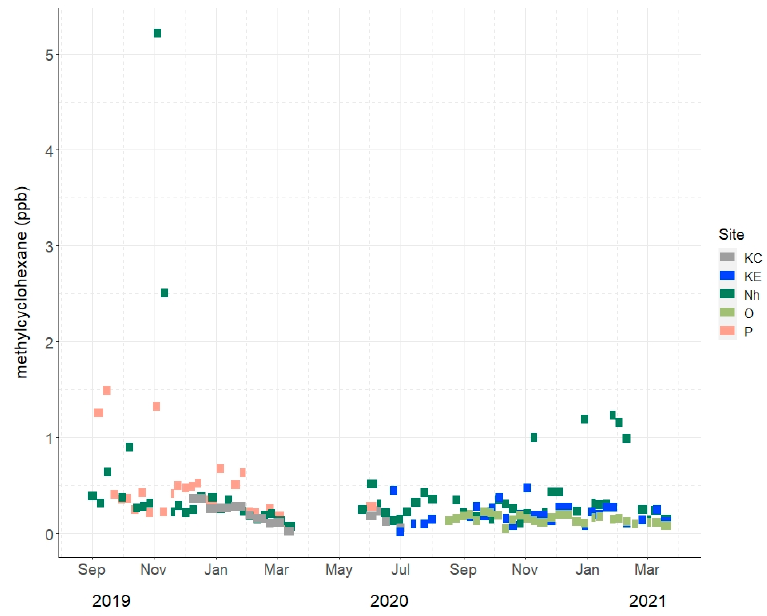
Figure 6. Methylcyclohexane time series for all sites, similar to Figure